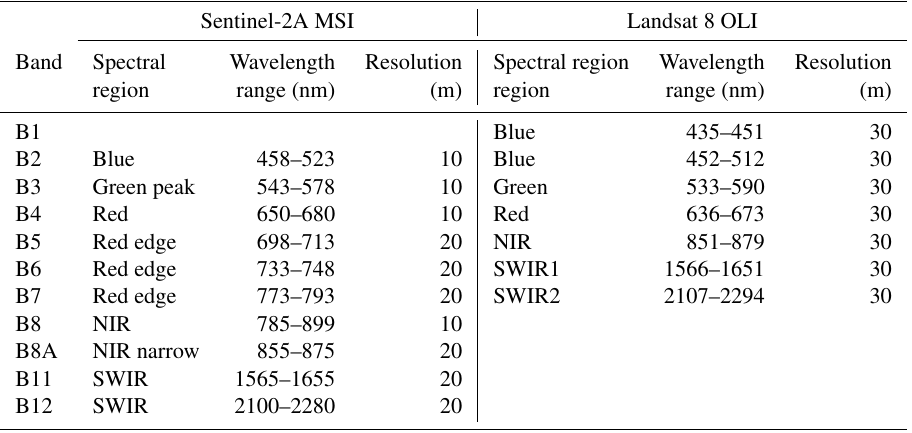
Table 1. Spectral bands range and spatial resolution of Sentinel-2A MSI and Landsat 8 OLI sensors simulated in this